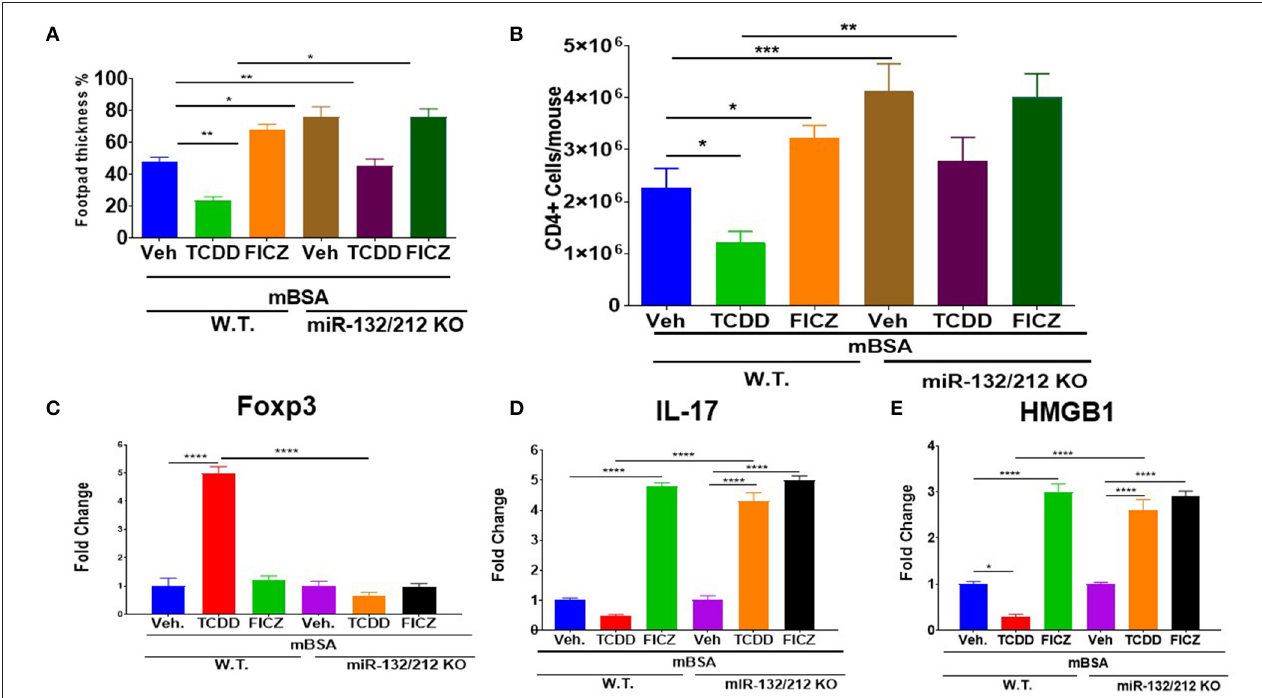
FIGURE 9 | Studies using miR-132/212 KO mice to assess the role of TCDD and FICZ on DTH response. DTH was induced as described in Figure 1 legend in wild-type (W.T.) mice and miR-132/212 KO mice and these mice were analyzed for footpad swelling and immunological parameters. (A) Showing the percentage of increase in the thickness of each footpad of WT and miR-132KO mice. (B) Absolute cell number of CD4 + cells in DLN in various groups. (C) qRT-PCR-based expression of mRNA for Foxp3 + . (D) qRT-PCR-based mRNA expression of IL17. (E) qRT-PCR-based mRNA expression of HMGB1. Vertical bars represent Mean ± SEM and significant differences between groups are shown with asterisks (* p < 0.05, ** p < 0.01, *** p < 0.001, **** p < 0.0001) based on one-way